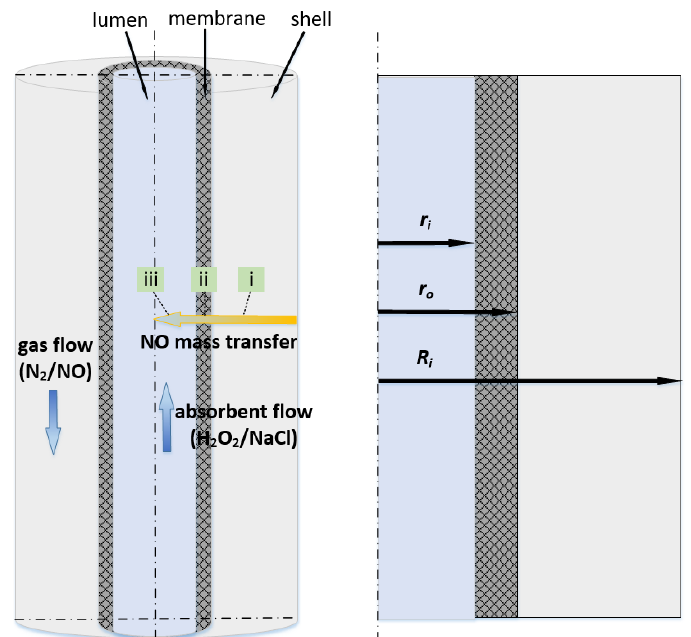
Figure 1. Schematic diagram of the ceramic HFMC.